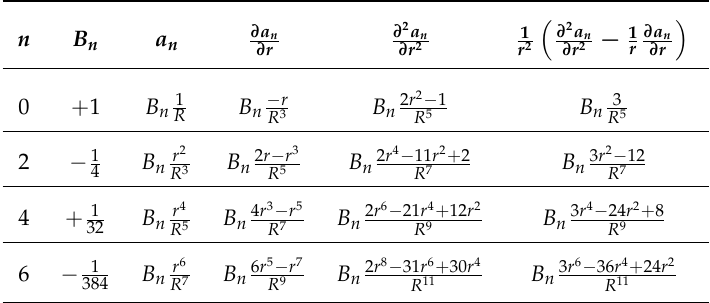
Table 1. Values of first few terms of a n and its